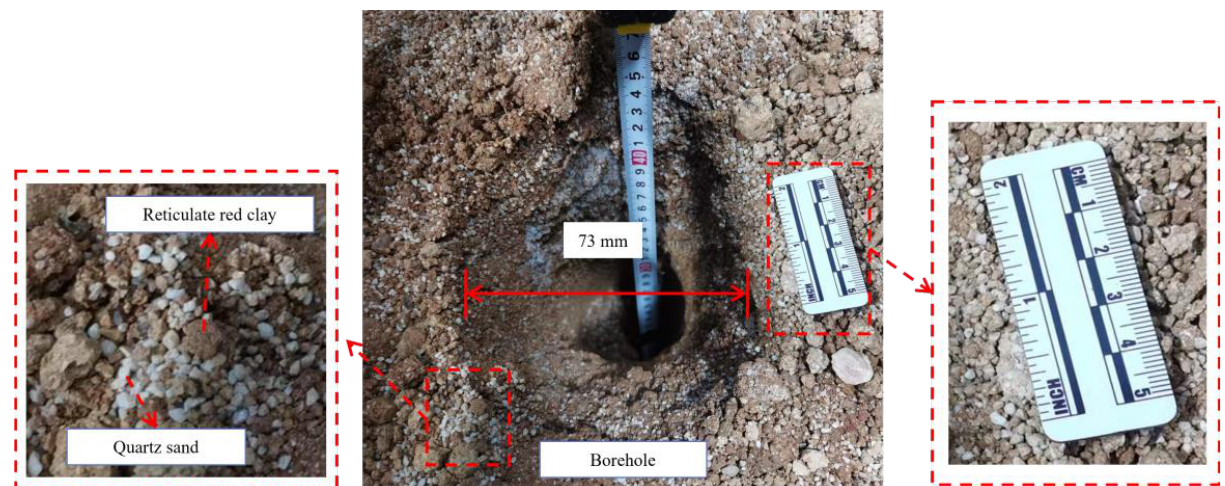
Figure 14. Direct push drilling effect of the C-DP drilling rig.